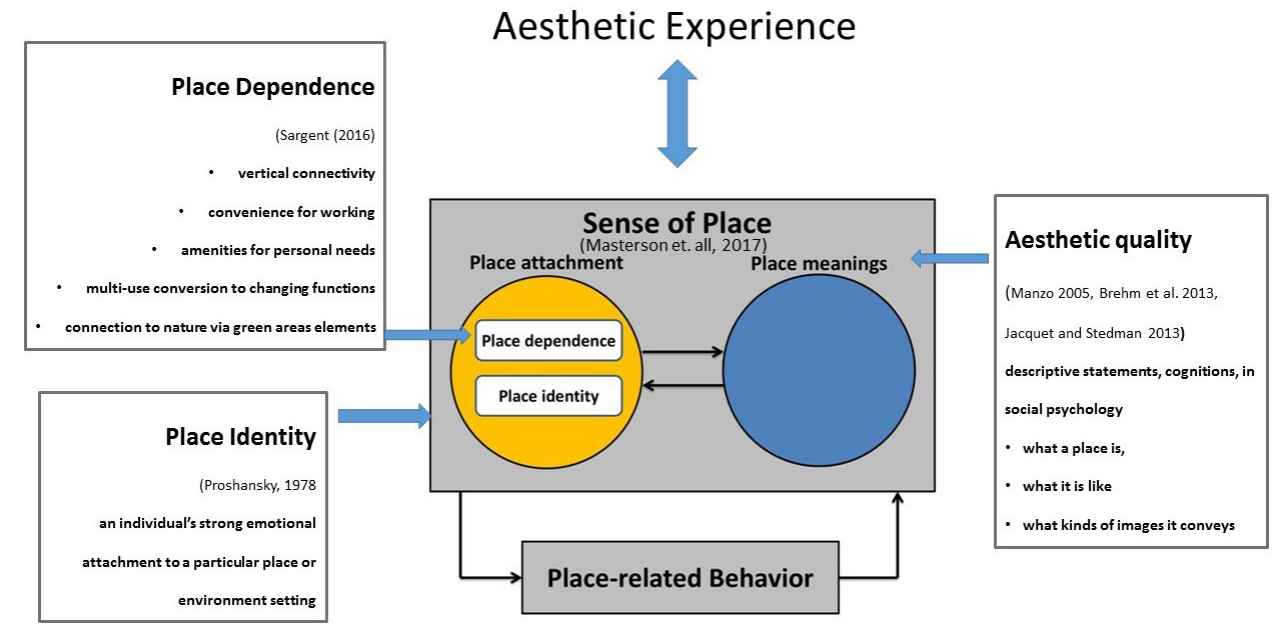
Figure 1. Aesthetic Experience of Campus (Developed by the